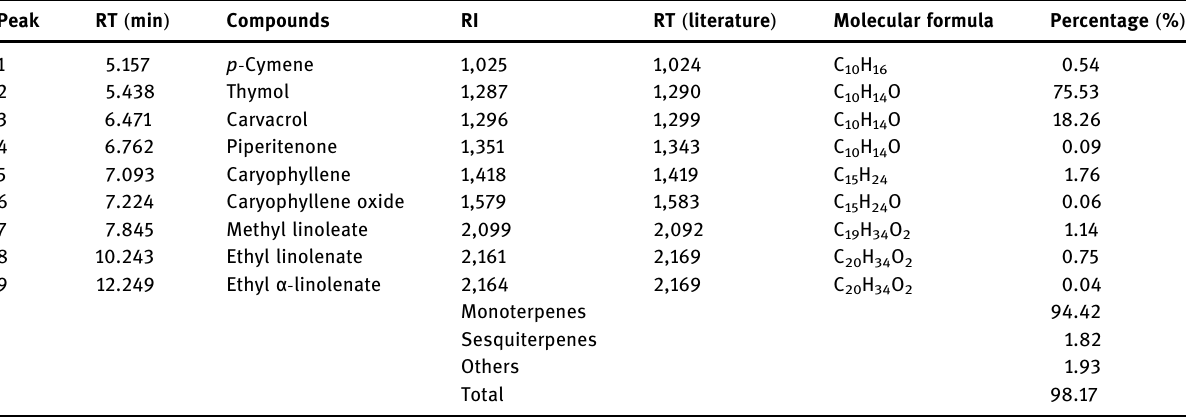
Table 1: Phytochemical composition of O. compactum EO Peak RT ( min